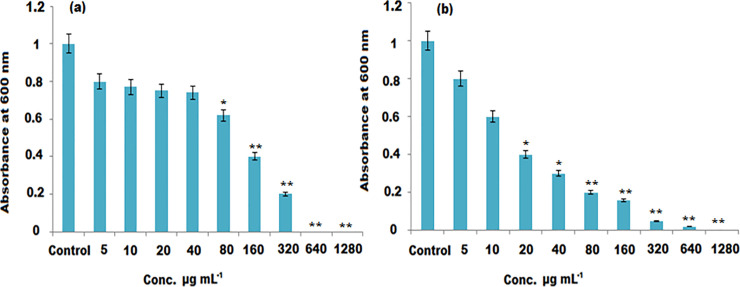
Minimum bactericidal concentrations (μg mL-1) of the MgONPs (Qustal bahri) against (a) E. coli (b) P. aeruoginosa. Results are expressed as Mean ± SD of triplicate experiments.